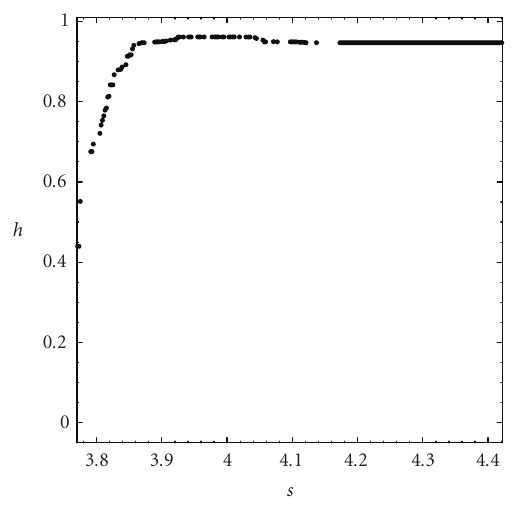
Figure 2.25. Variation of the topological entropy for I = 3 . 25, r = 0 . 005, and s ∈ [3 . 77, 4 .